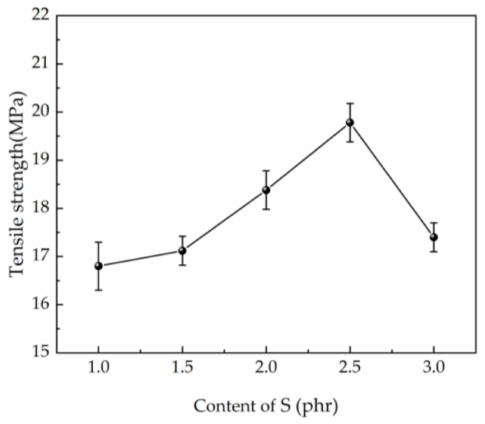
Figure 18. The relationship between the content of S and tensile strength.